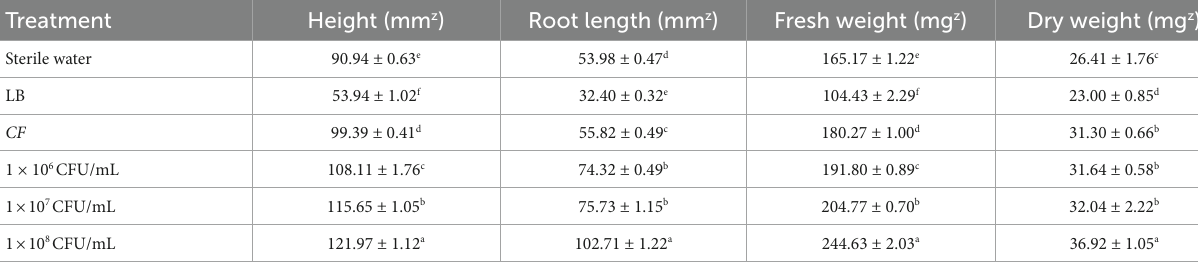
TABLE 3 Effect of Bacillus amyloliquefaciens DB2 suspension on the growth of wheat seedlings.